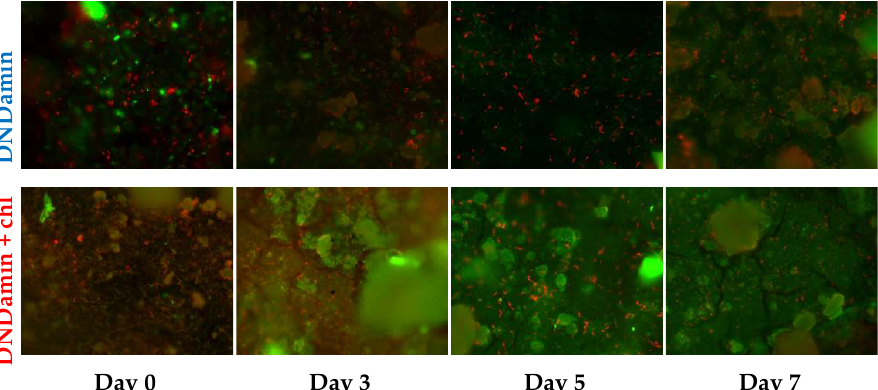
Figure 5. Images of modified polymers samples (1200×) after incubation in medium with Saccharo- myces cerevisiae yeast at 28 °C for various times and fluorescent staining. The cells are shown in red, romyces cerevisiae yeast at 28 ◦ C for various times and fluorescent staining. The cells are shown in red, the polysaccharide biofilm matrix is indicated in green. the polysaccharide biofilm matrix is indicated in